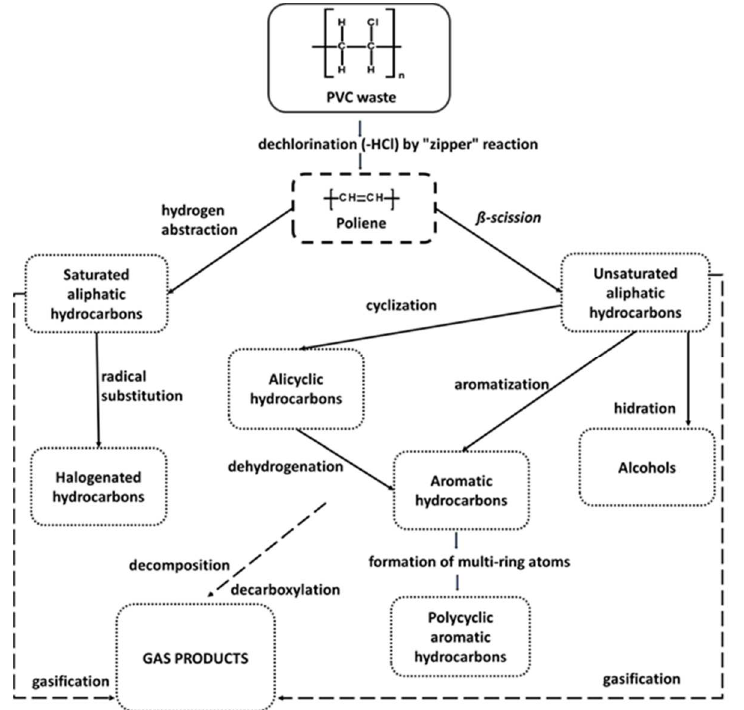
Figure 4. Degradation mechanisms of PVC waste in SCW.